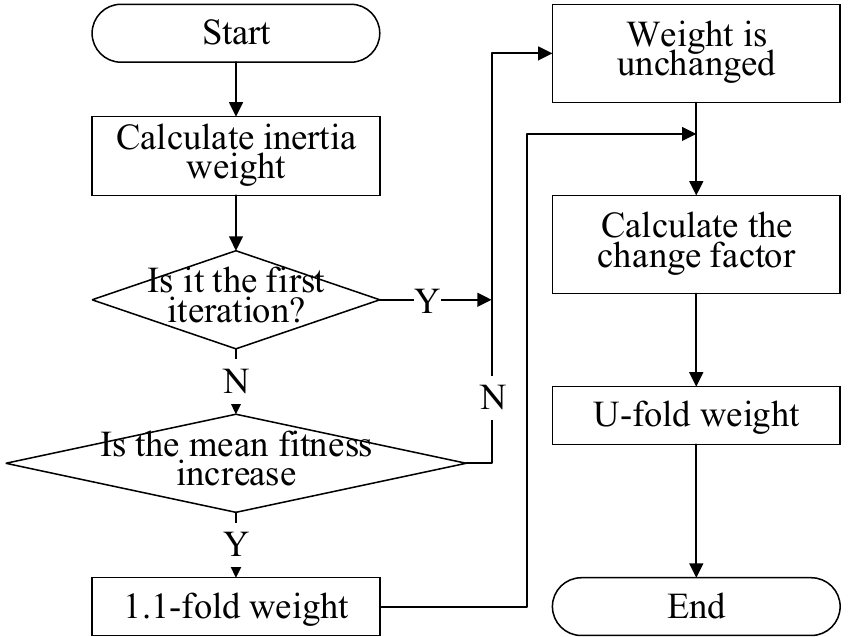
Figure 5. Flow chart of self ‐ adaptive inertia weight algorithm in iterative inversion process.